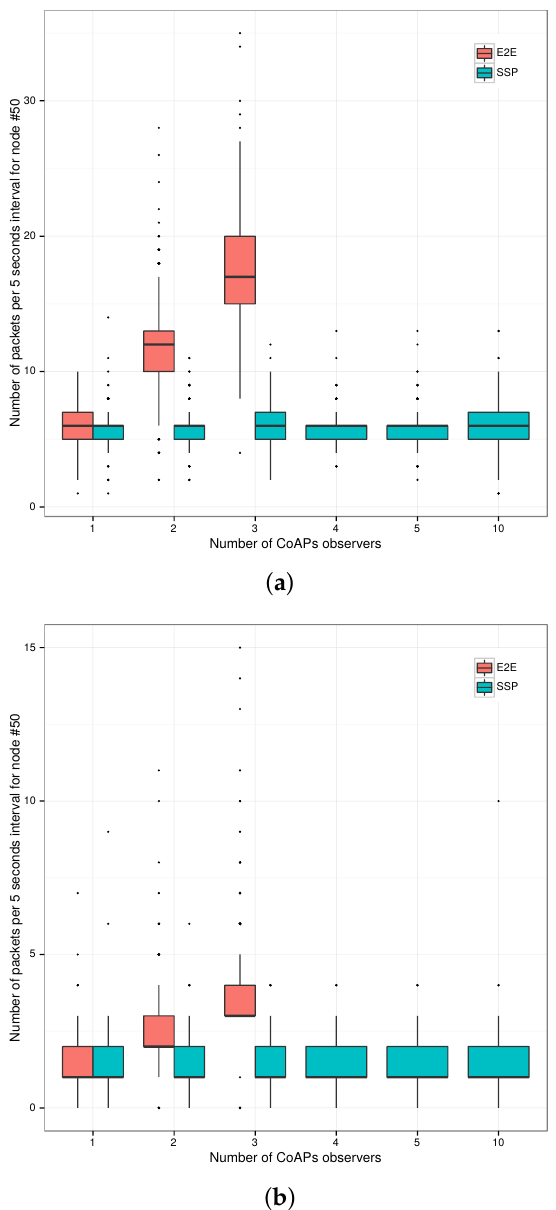
Figure 10. Number of exchanged packets for Node #50 per five-second interval for E2E CoAPs observation versus CoAPS observation through the SSP. ( a ) One-second notification interval; ( b ) five-second notification